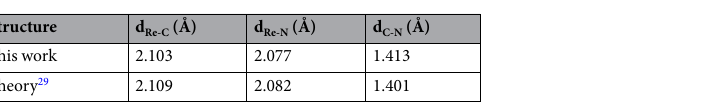
Structure d Re-C (Å) d Re-N (Å) d C-N (Å) This work